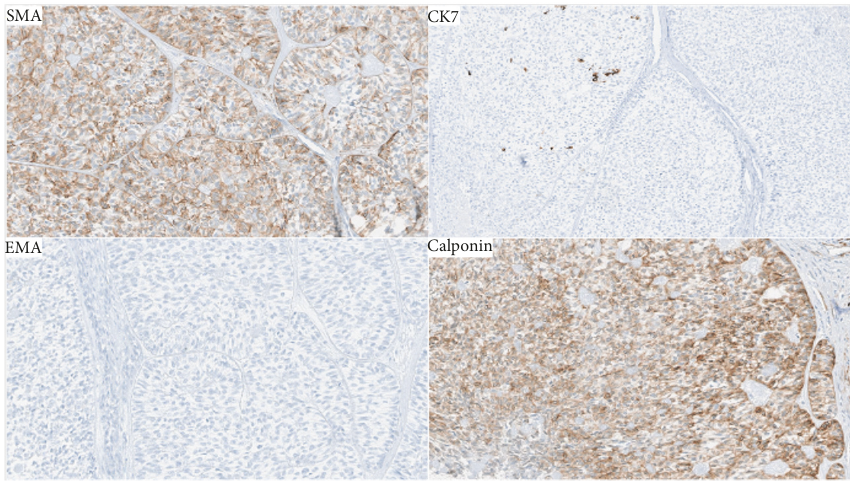
Figure 4: Immunohistochemical staining showing tumor positivity for SMA (smooth muscle actin) and calponin. CK7 was overall negative with a small fraction of the tumor showing patchy positivity. EMA was